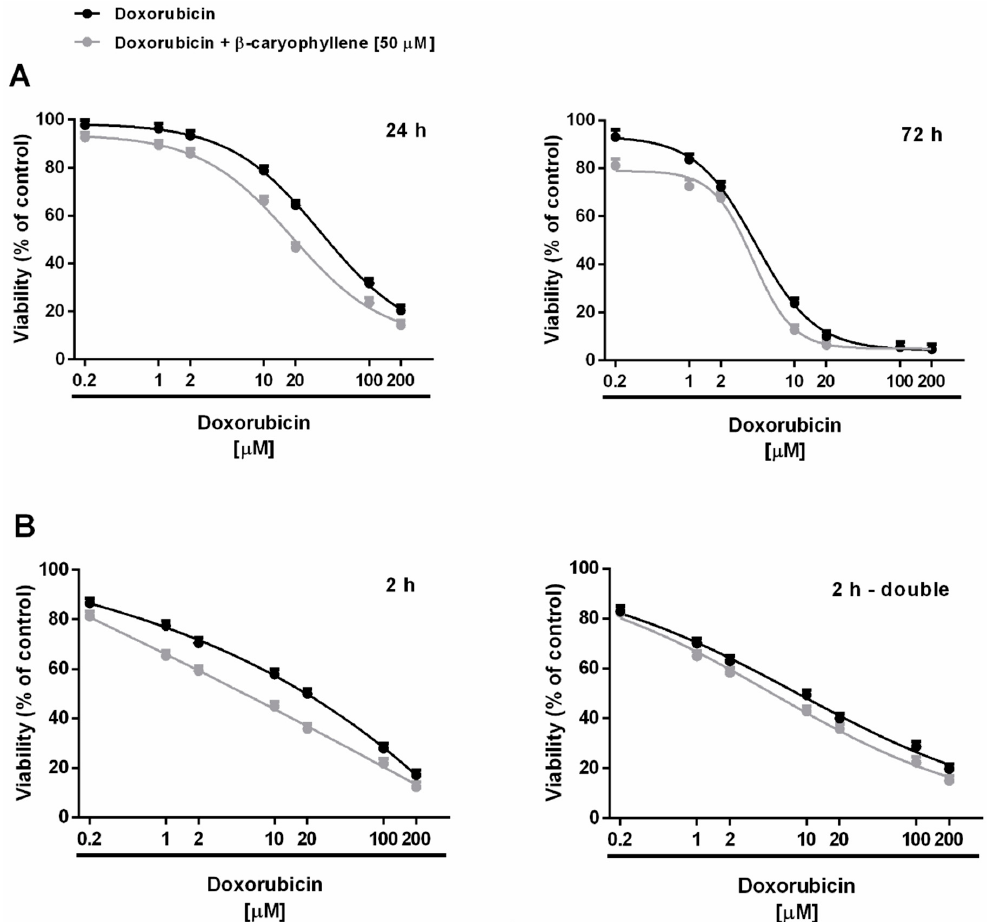
Figure 3. Cytotoxicity of doxorubicin and its combination with β -caryophyllene in Mz-ChA-1 cholangiocarcinoma cells. ( A ) Single long-term exposures of 24 h and 72 h. ( B ) Metronomic schedule: the cells were subjected to a single and / or double repeated short exposure of 2 h followed by a recovery time of 72 h. Data are expressed as mean ± SE (standard error) of at least two experiments in which each treatment was tested at least in triplicate ( n = 6).